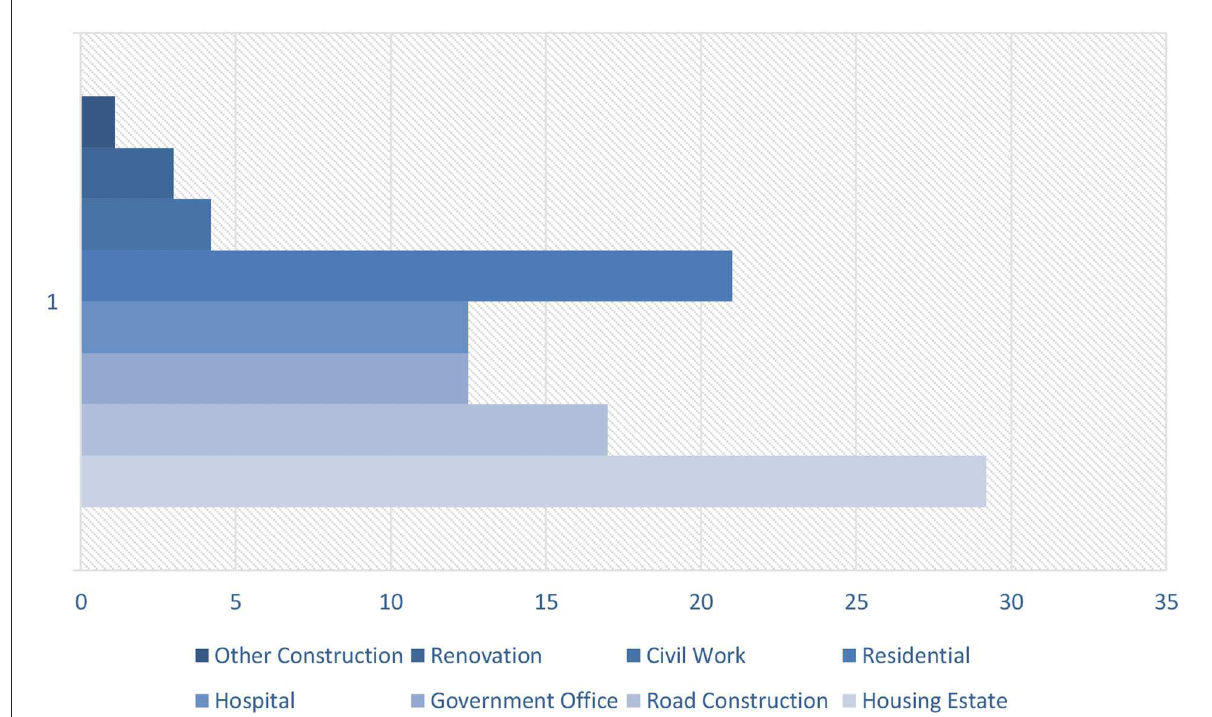
FIGURE5 Respondents’ demography according to the project executed